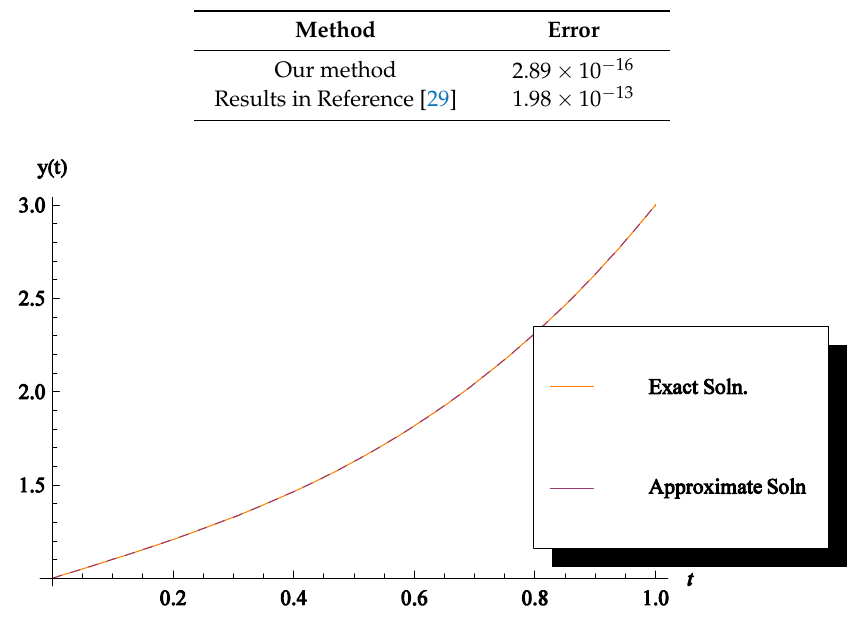
Table 3. Comparison between our results and the results in Reference [29] for Example 3.